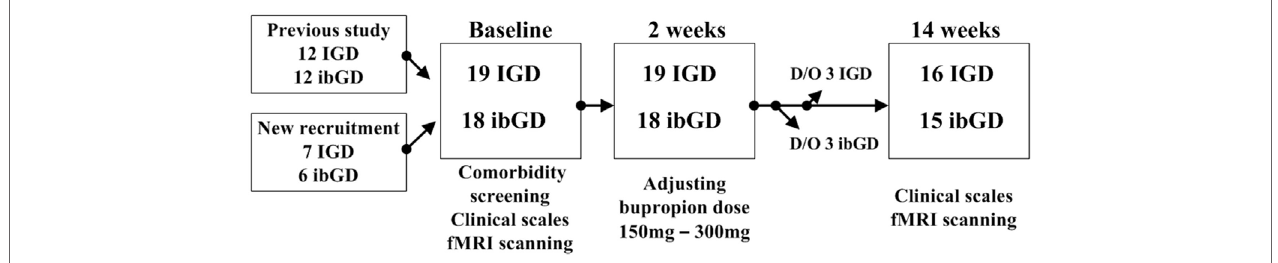
FigUre 1 | Study procedure. Abbreviations: IGD, Internet gaming disorder; ibGD, Internet-based gambling disorder; D/O, dropped out; fMRI, functional magnetic resonance